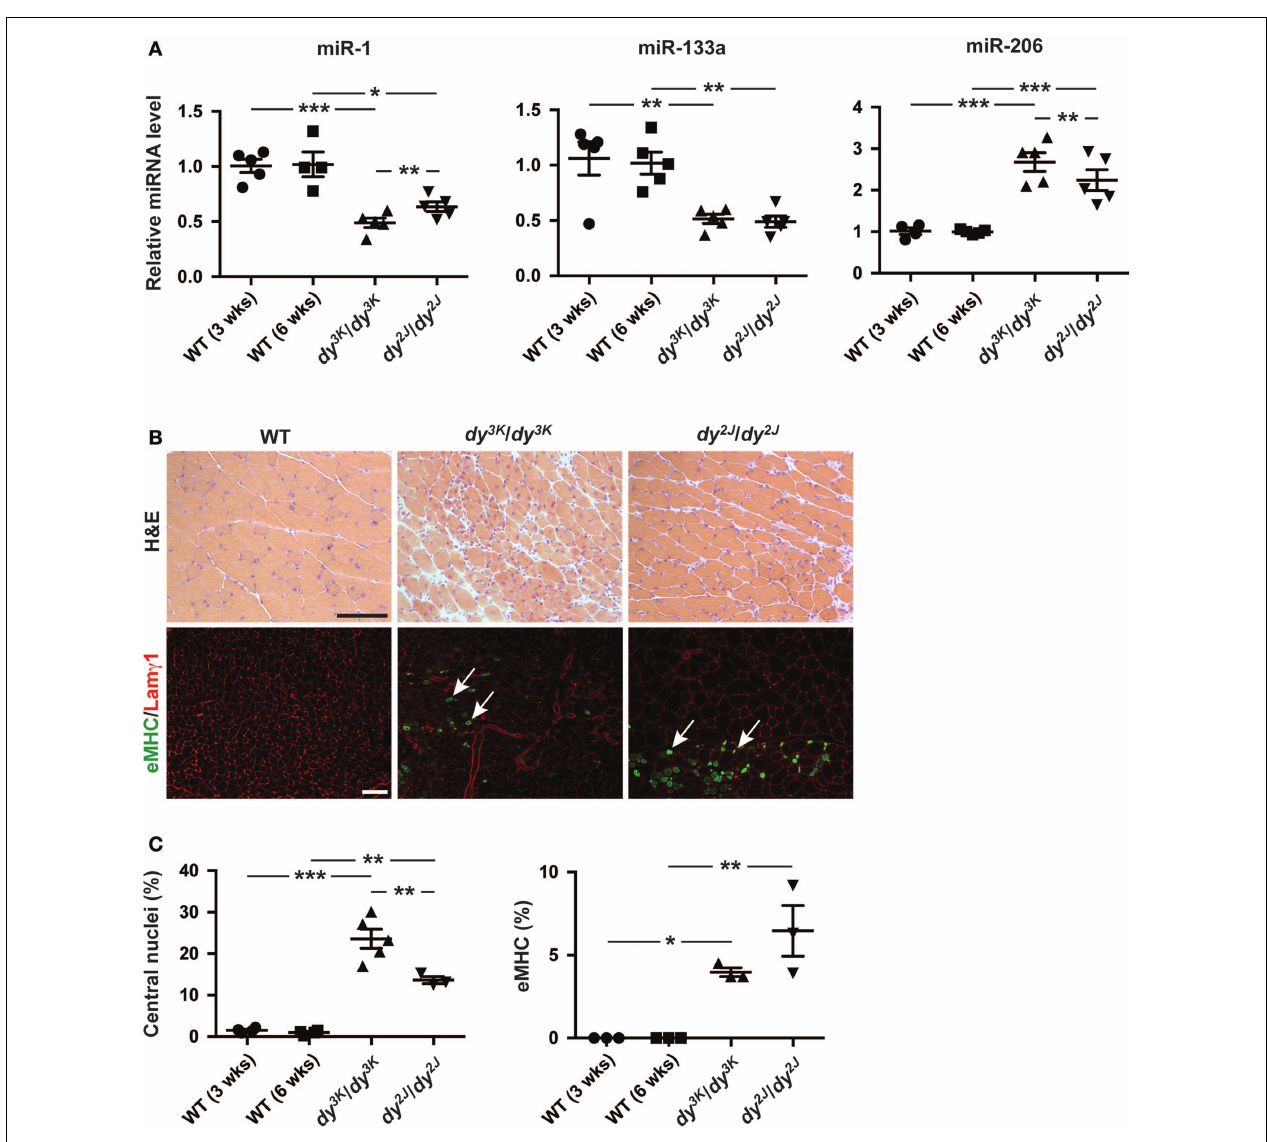
regenerating fibers. Arrows indicate eMHC positive cells (green). Bar, 100 µ m. (C) Percentage of fibers with centralized nuclei or positive for eMHC in muscles fromWT, dy 3K /dy 3K , and dy 2J /dy 2J mice ( n ≥ 3).WT, wild-type; H&E, hematoxylin/eosin; eMHC, embryonic myosin heavy chain; Lam γ 1, laminin γ 1 chain. Error bars represent SEM, * P < 0.05, ** P < 0.01, *** P <